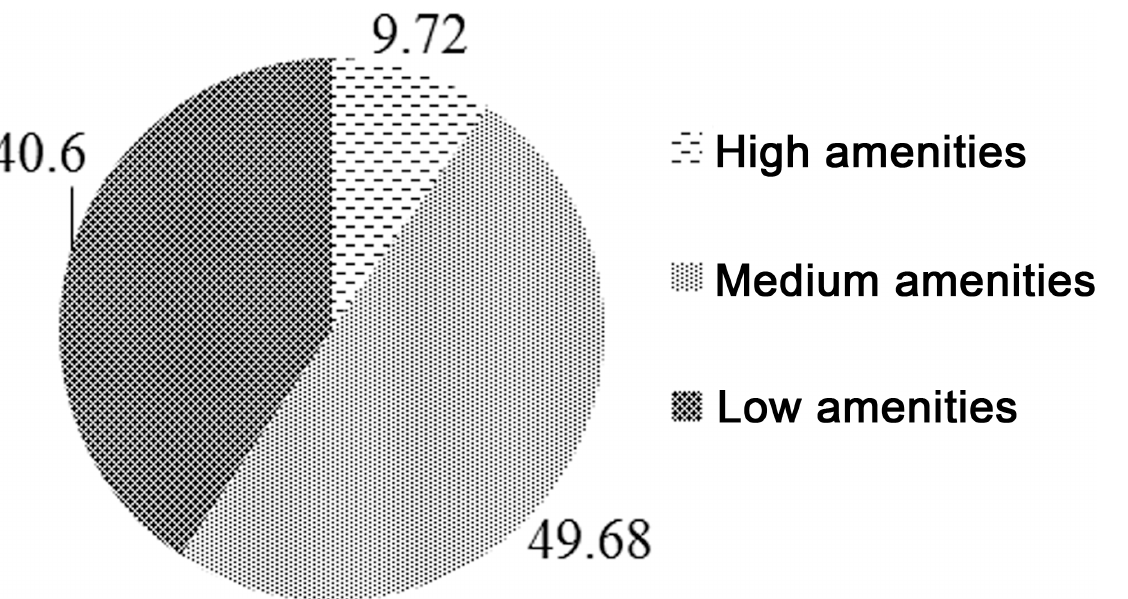
Fig 1. Children in 0 – 59 months by level of Macro Amenities Index (MAI) in Northeast India. Source: Based on authors computation from Census 2001 – 2011 and NFHS-3 (2005 – 06)